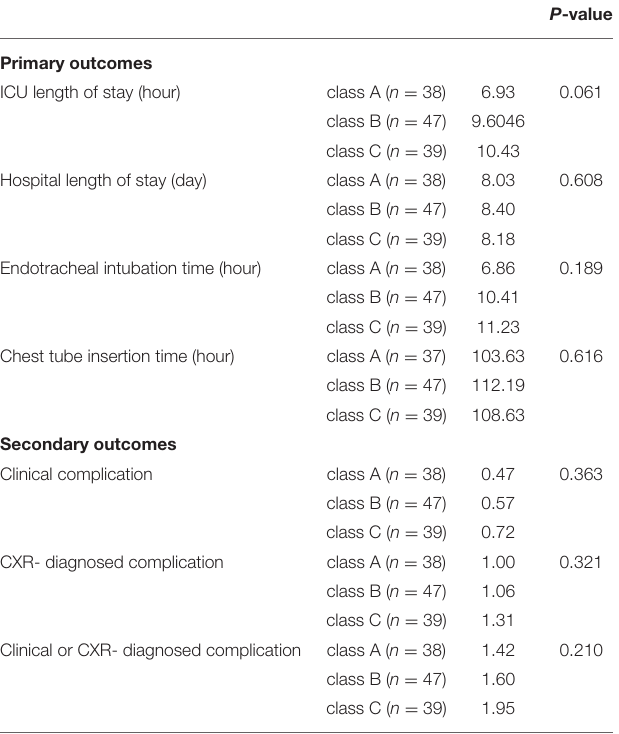
TABLE 3A | Outcomes comparisons by peak oxygen consumption (peak VO 2 ). TABLE 3B | Outcomes comparisons by oxygen consumption at anaerobic threshold (VO 2 at